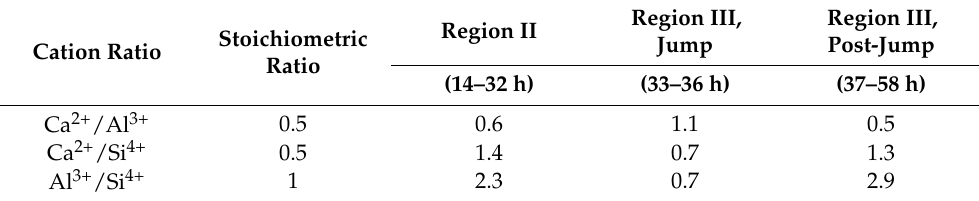
Table 7. Ratios of cation accumulation during flow-through dissolution. Data generated through linear regression of the slopes in Figure 4.